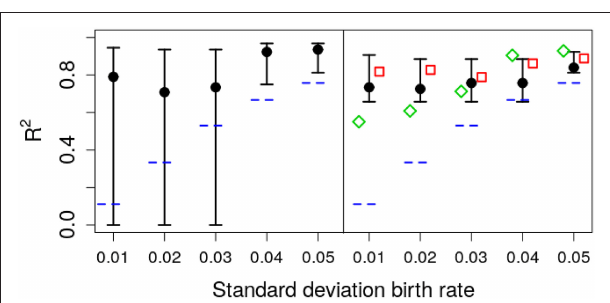
FIGURE 7 | Estimated R 2 with increasing standard deviation for the growth rate. The data in all cases was generated by a pure birth process with parametric variability. The horizontal short dashed lines indicate the parameter values used in the data generation. The left panel corresponds to the stochastic fits and the right panel to the deterministic fits, where the vertical whiskers are the 95% CI obtained in the fits. The red empty squares in the right panel stand for the value of R 2 calculated with Equation (5) at time t = 20 with parameters estimated using standard linear mixed-effect models (regression). The empty green diamonds are an alternative way to estimate R 2 using the empirical data variance and the theoretical (stochastic) noise variance, Equation (8). In each case, the number of observations per unit was O =